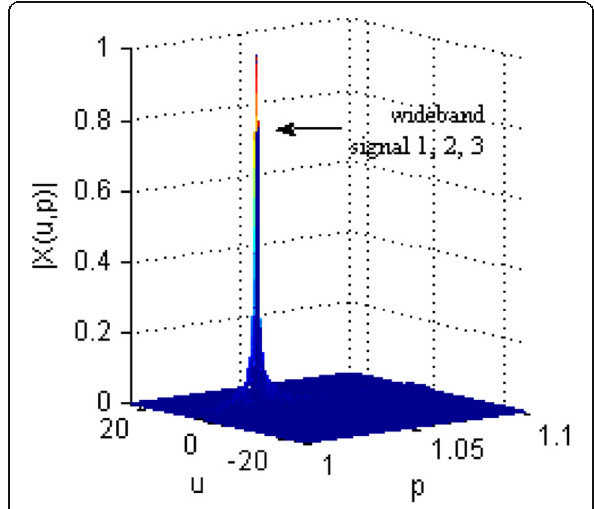
Fig. 2 Energy distribution of coherent LFM signals in the FRFT